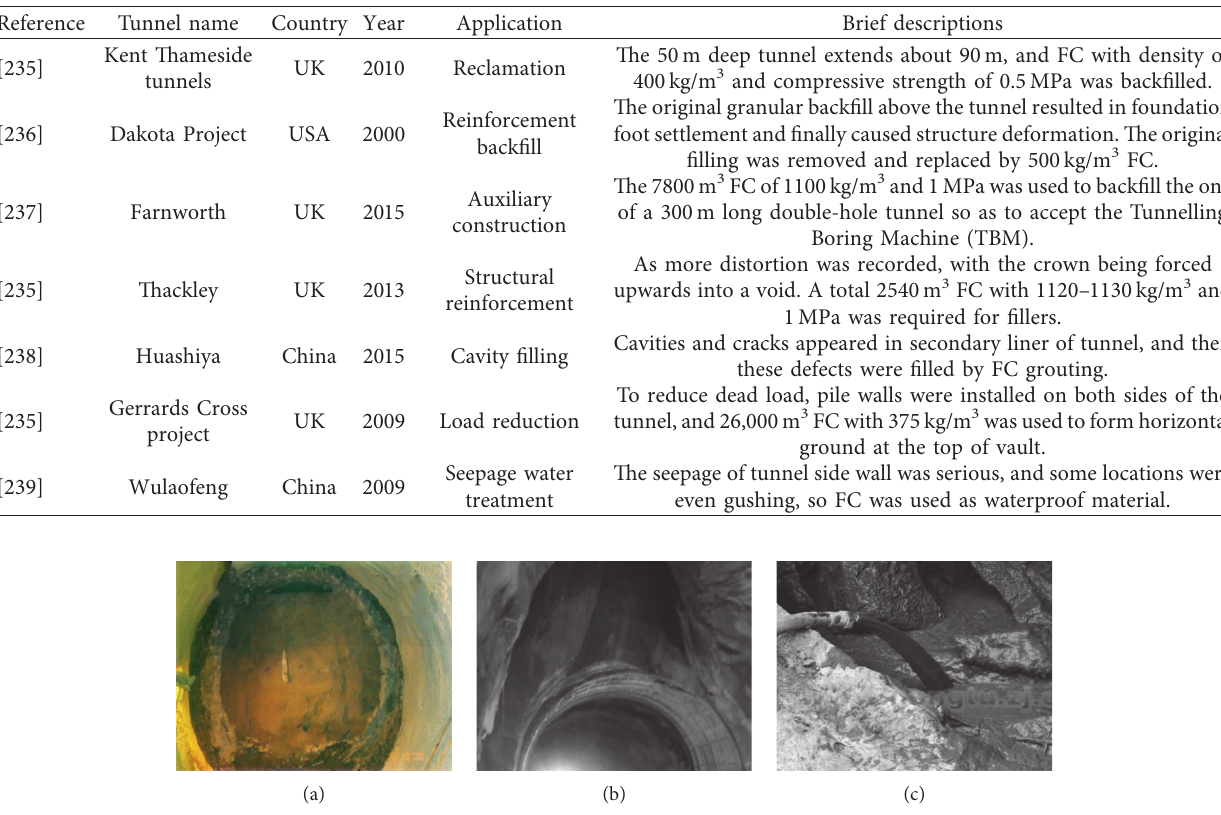
Table 9: Application examples of selective fill with FC.